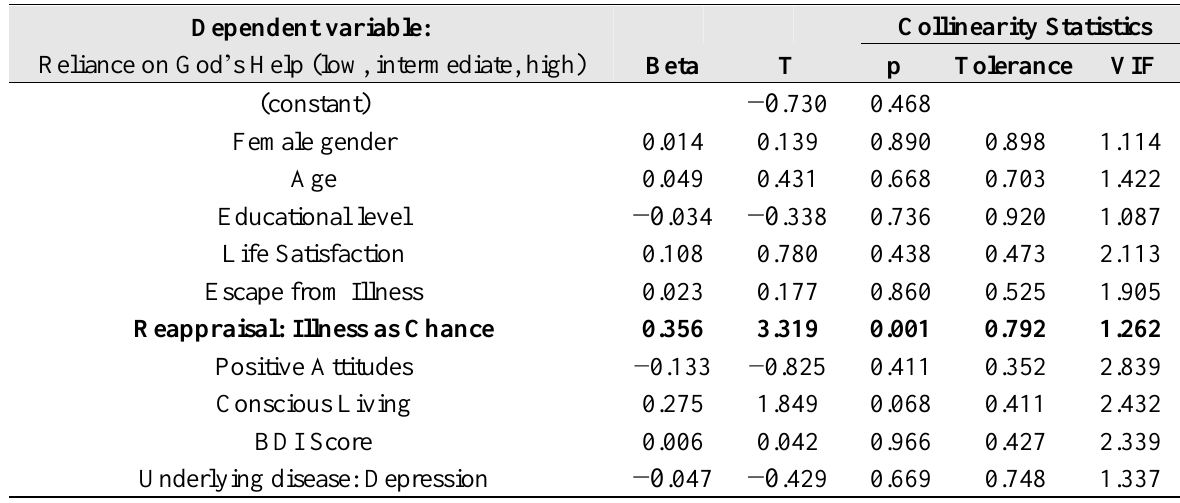
Table 4. Regression